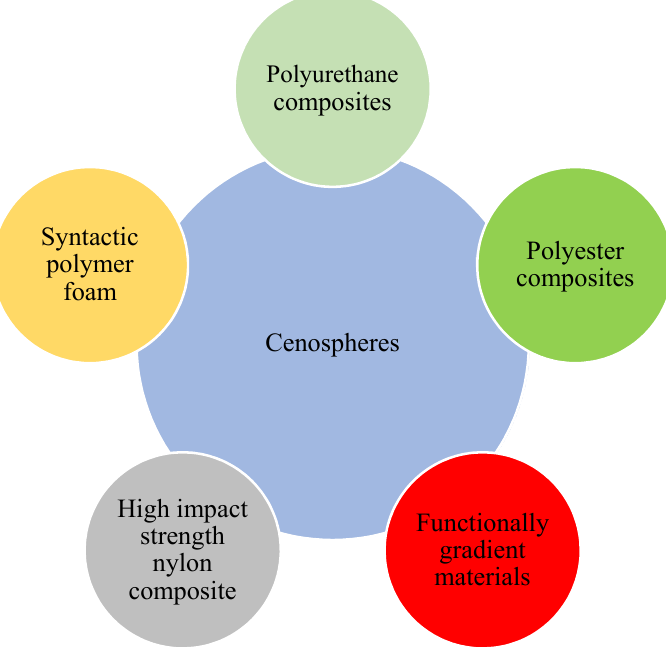
Figure 1. Applications of cenospheres as a filler in composites and